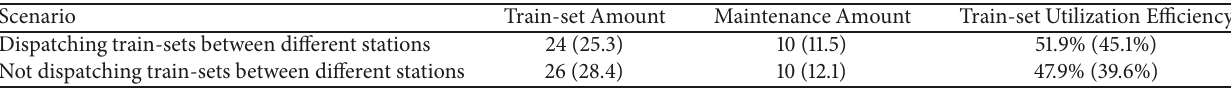
Figure 6: Topological structure of case study. Table 4: Computational results between two different utilization modes.